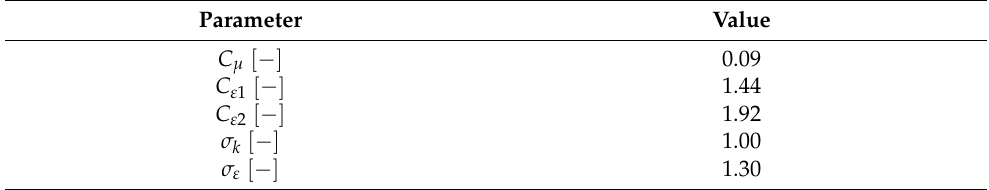
Table A1. Values of the empirical constants in the standard k − ε model [47,49]. Parameter